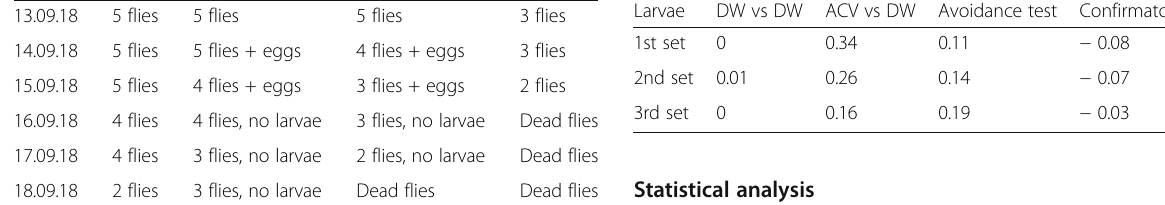
Statistical analysis